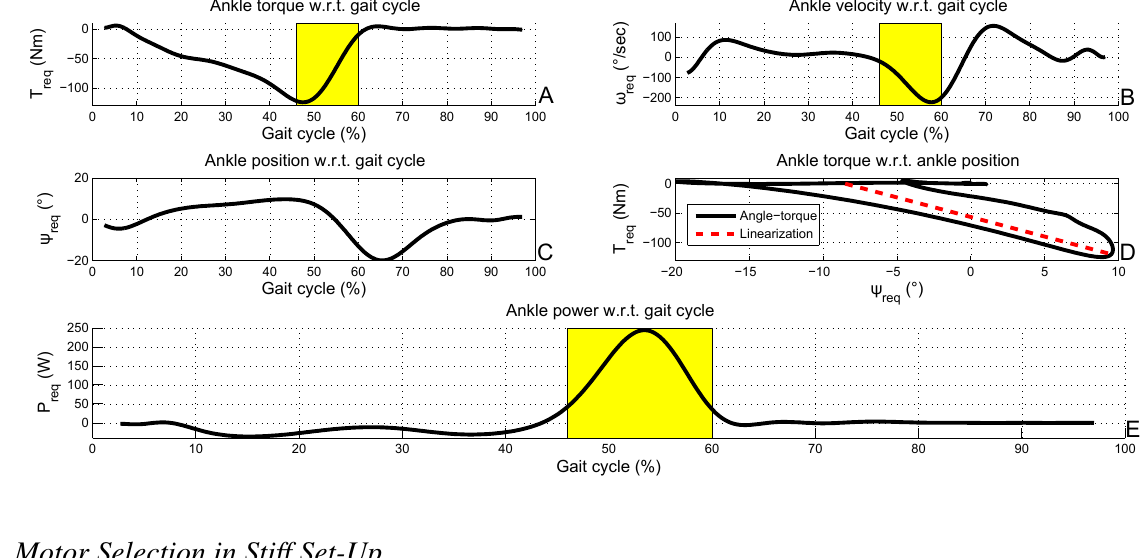
Figure 1. Torque, velocity, position, angle-torque and power graphs (respectively (A–E)) as a function of the gait cycle for an ankle of a 75 kg person, taken from Winter [1]. The yellow shaded areas correspond to the part of the gait cycle with the peak power during push-off. The dashed line in (D) is the linear fit of the solid torque-angle